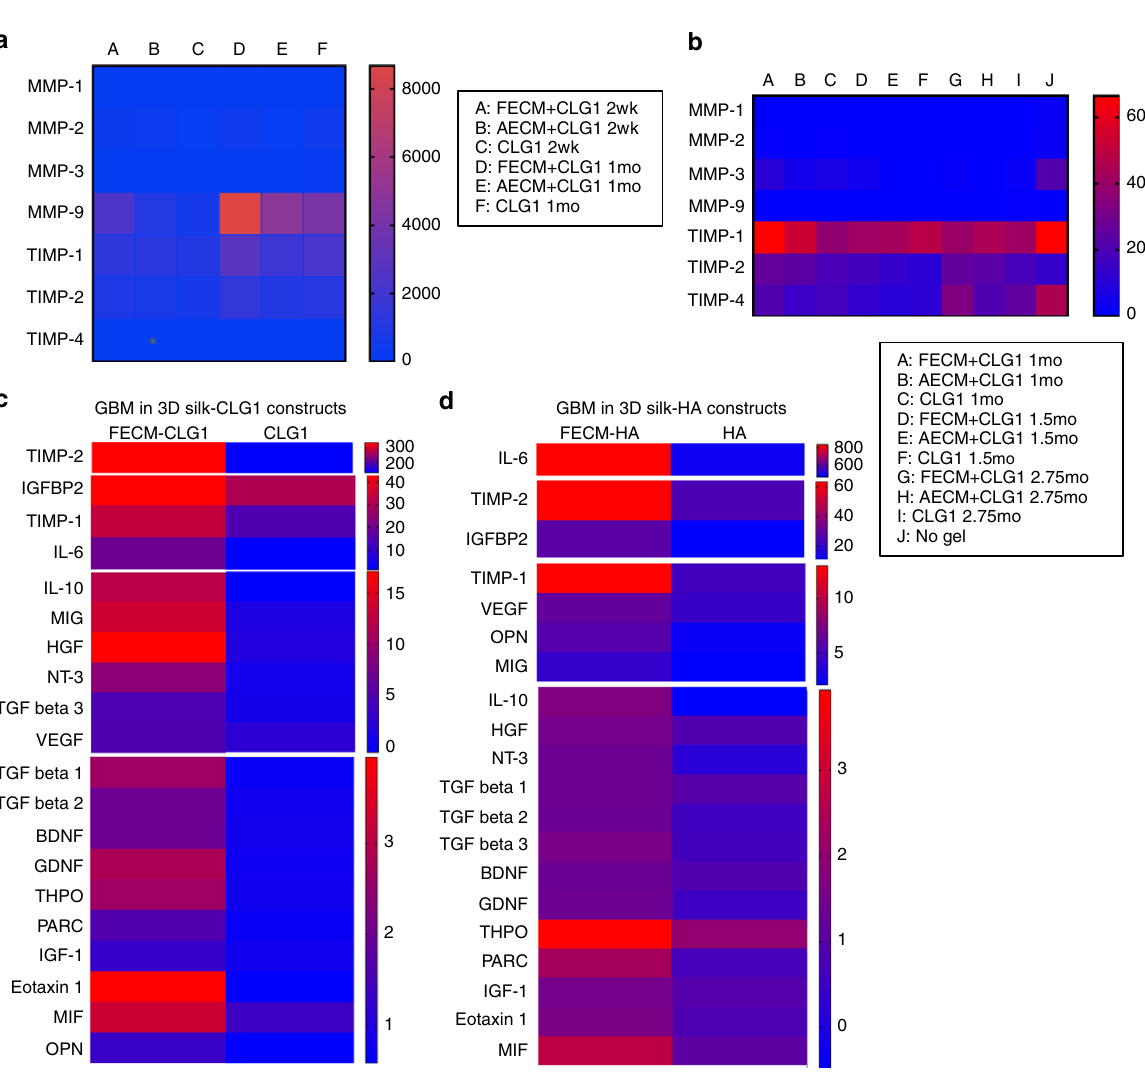
Fig. 5 Cytokine and MMP/TIMP media pro fi ling from 3D bioengineered cultures. a MMP/TIMP release pro fi le (reported in pg mL − 1 ) of 3D ependymoma cultures infused with CLG1-based hydrogels. n = 5 pooled samples per condition. b MMP/TIMP release pro fi le (reported in pg mL − 1 ) of 3D GBM cultures infused with CLG1-based hydrogels alongside 3D GBM constructs with no hydrogel added. n = 5 pooled samples per condition. c Cytokine release pro fi le at 1 mo of 3D GBM cultures infused with CLG1-based hydrogels (reported as fold change over control media). n = 7 pooled samples per condition. d Cytokine release pro fi le at 6.5 mo of 3D GBM cultures infused with HA-based hydrogels at 5.5 mo time point (reported as fold change over control media). n = 5 pooled samples per condition. Supplementary Table 1 lists the full forms of the cytokine abbreviations. Source data are provided as a Source Data fi